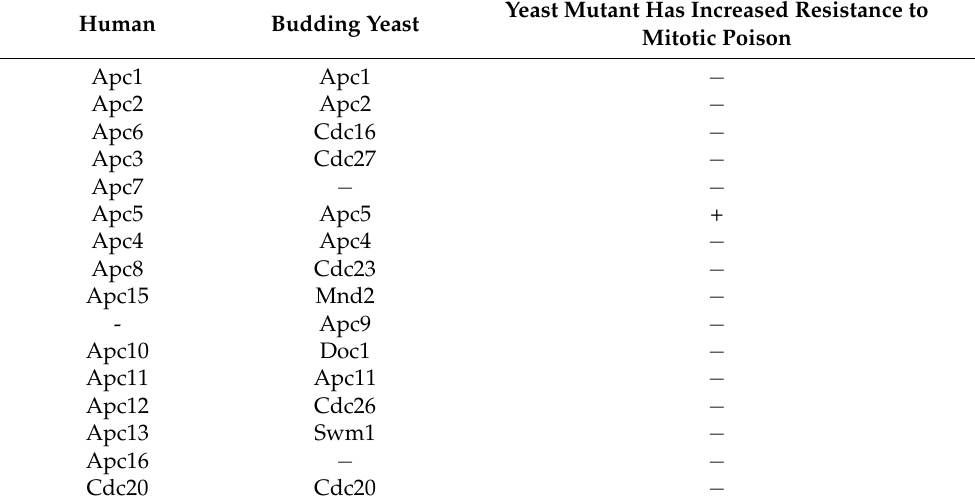
Table 1. APC/C Cdc20 subunits from human and budding yeast. Only a mutation in yeast Apc5 is known to display the very unique phenotype of an increased resistance to a mitotic poison (denoted as a “+” sign)